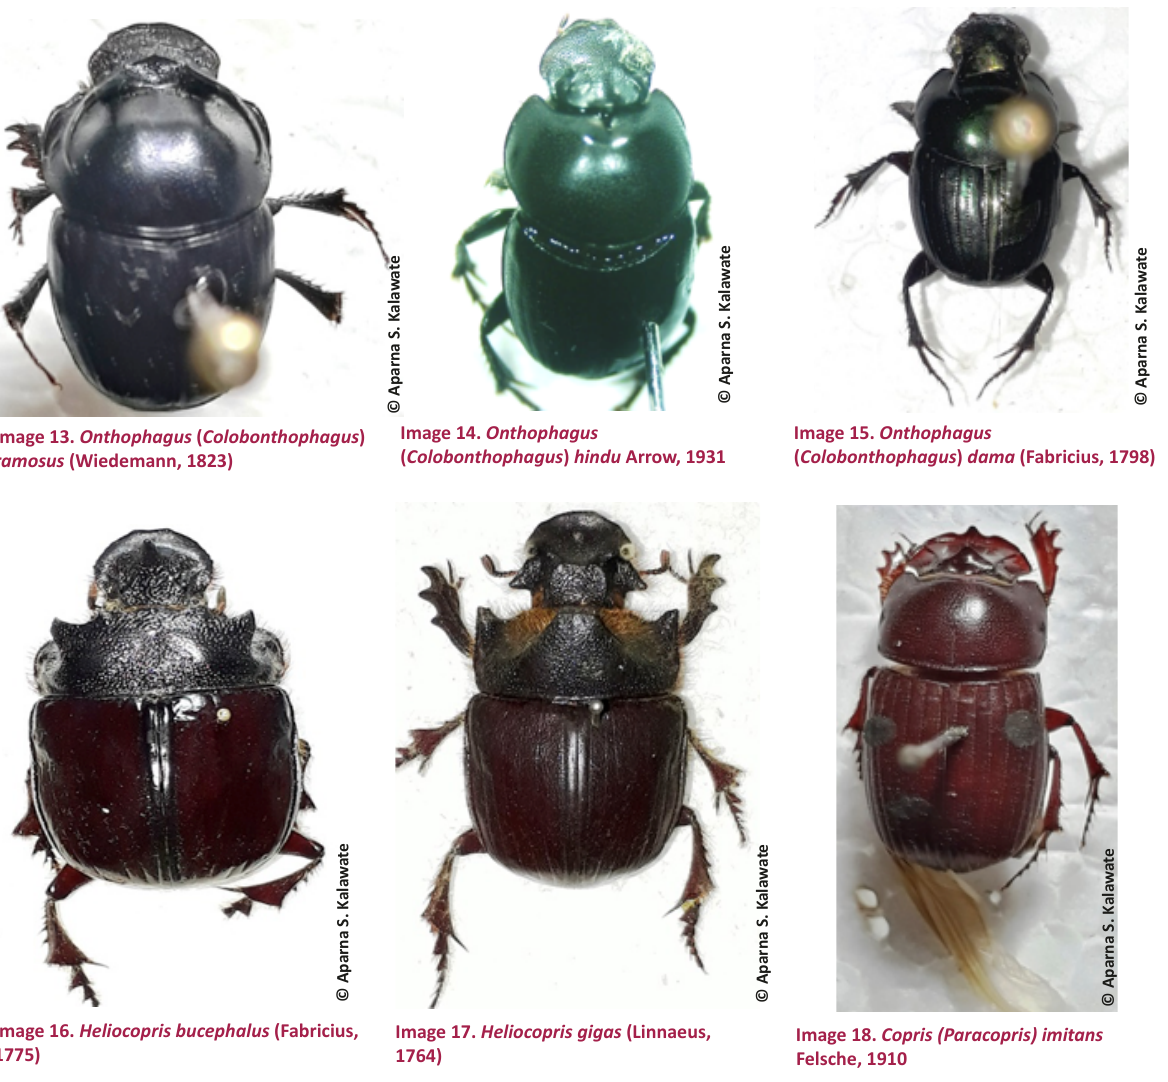
Image 18. Copris (Paracopris) imitans Felsche,